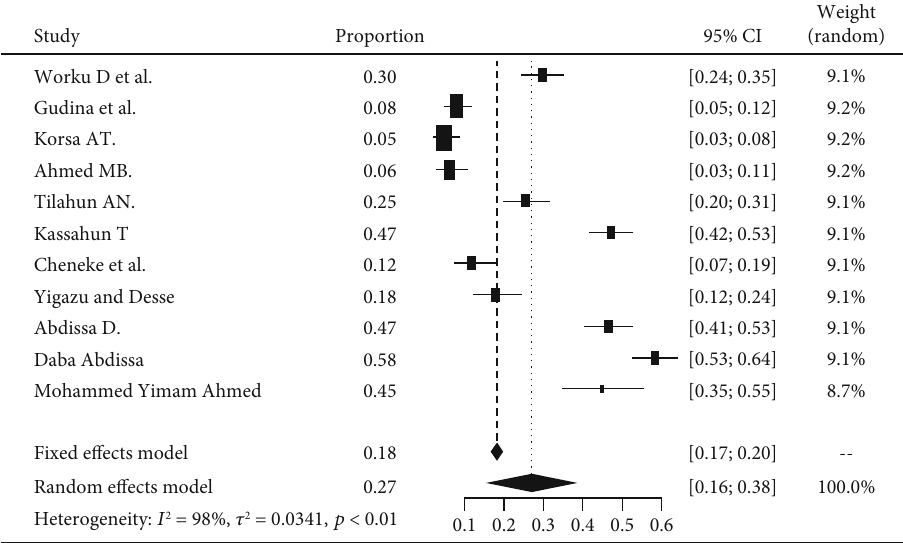
Figure 5: Forest plot of DPN in the Oromia region.